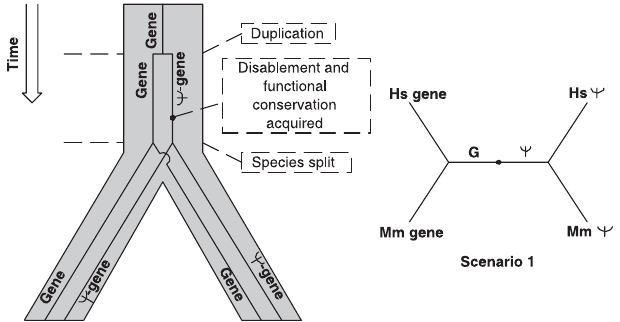
Figure 1. Evolutionary Scenario S 1, Describing the Case where the Pseudogene Originated before the Species Split and Has Acquired as well as Maintained Function G and w on tree branches refer to gene and pseudogene evolution,